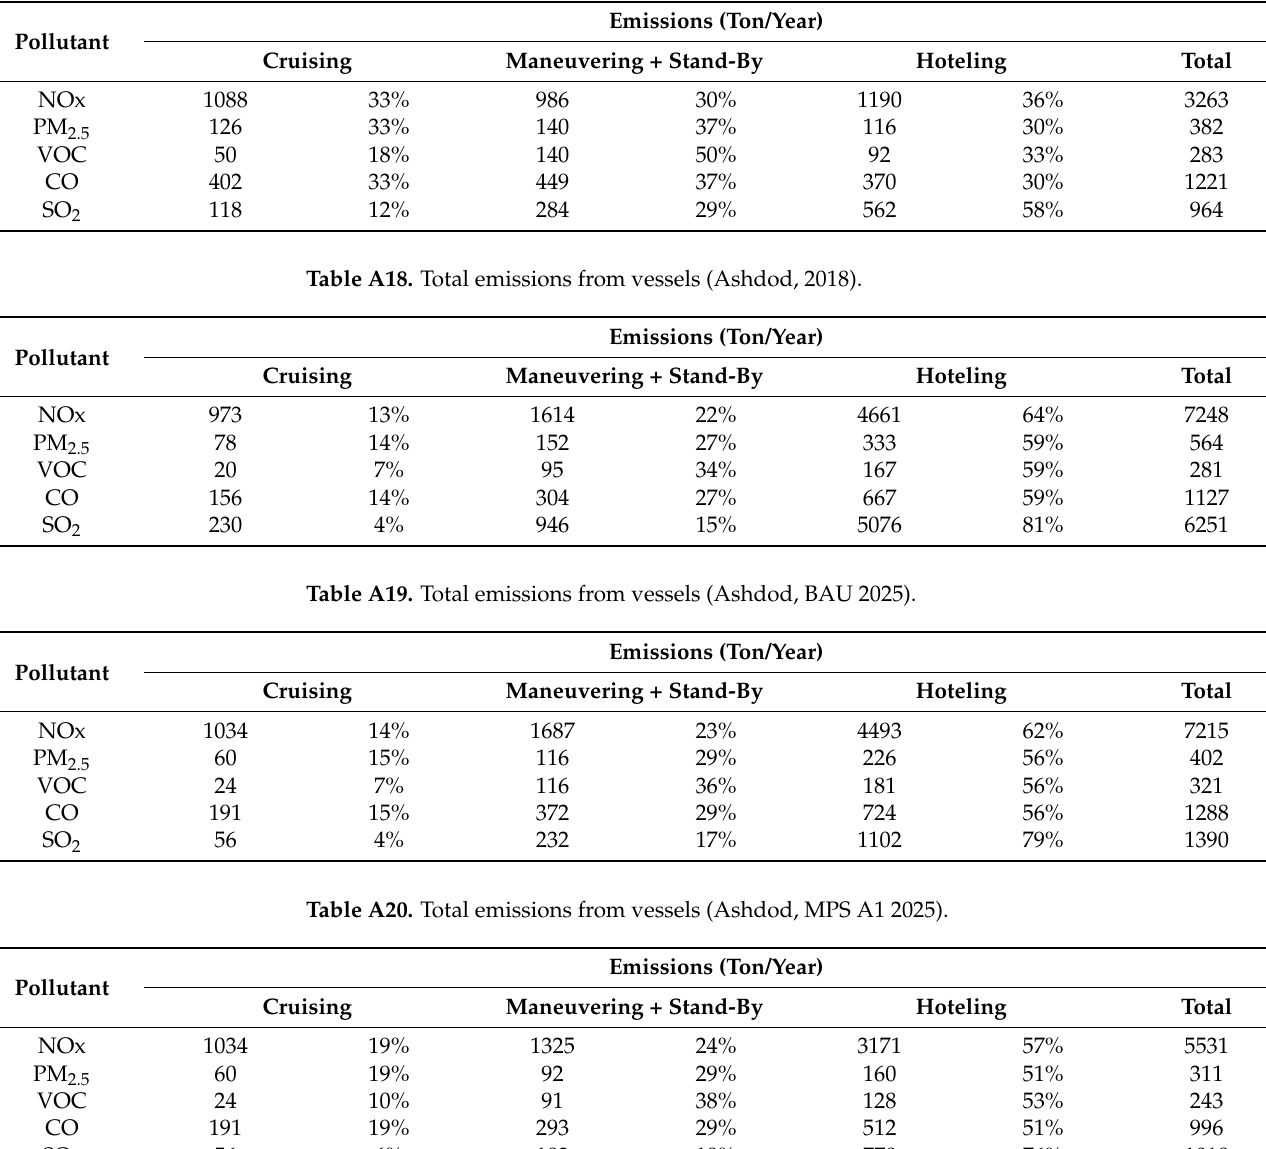
Table A17. Total emissions from vessels (Haifa, MPS 2030).